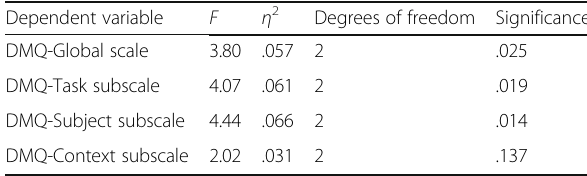
Table 3 MANOVA including DMQ-Total, DMQ-Subject, DMQ-Task, DMQ-Context, and Pre-Task Workload. Inter-subject tests